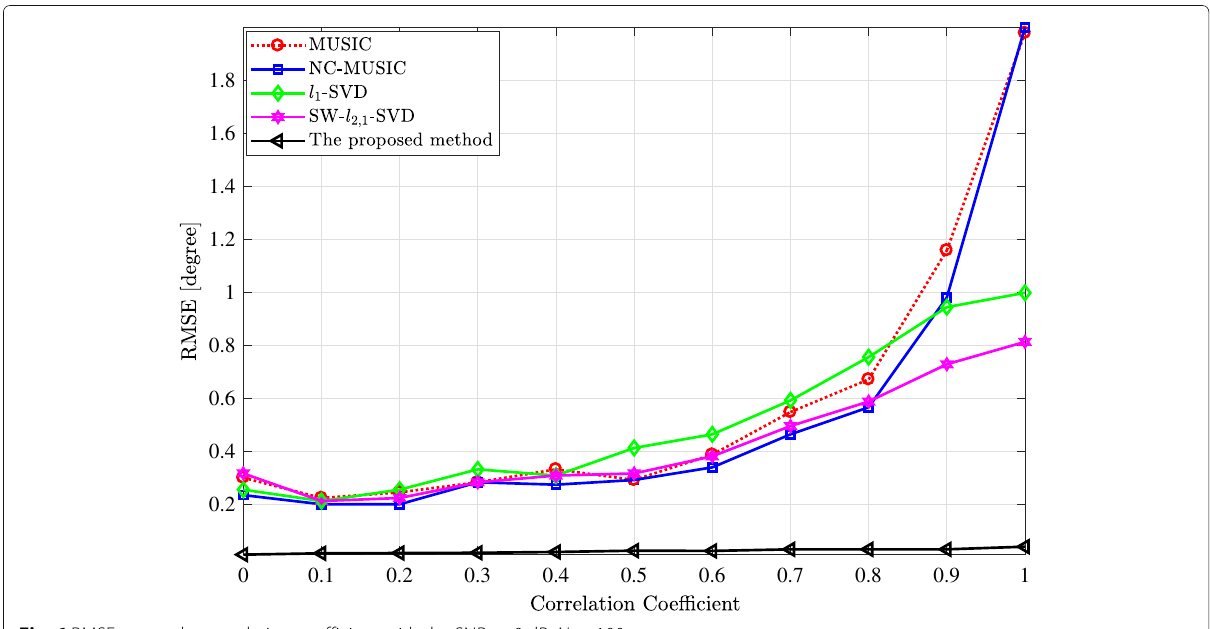
Fig. 6 RMSE versus the correlation coefficient with the SNR = 0 dB, N = 100